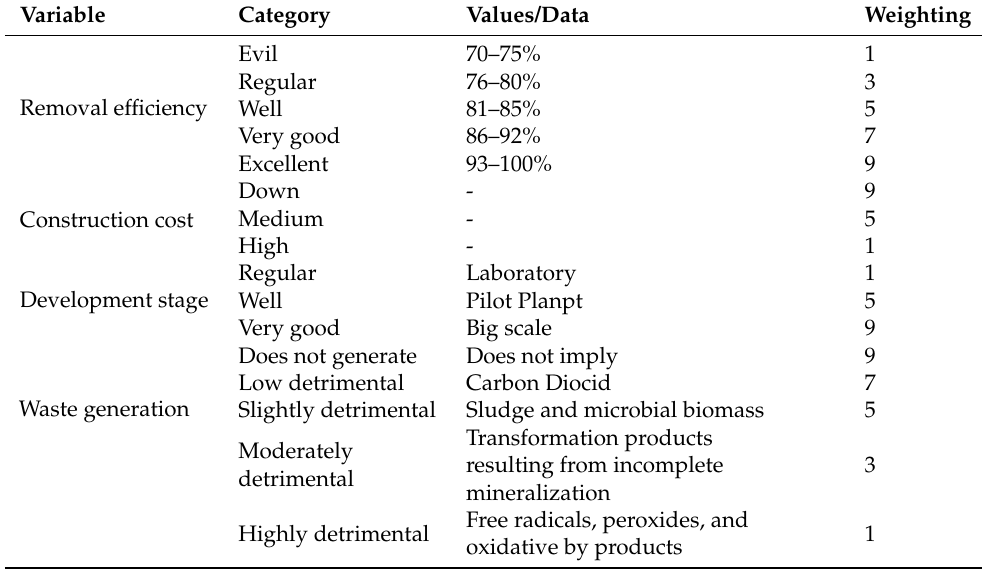
Table 1. Weighting of the study variables.